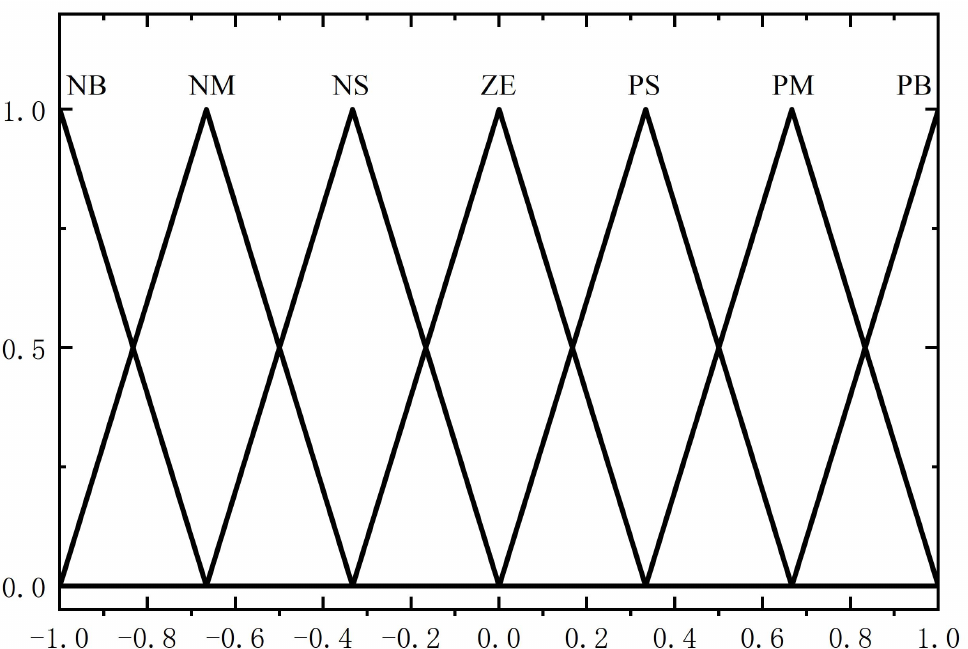
Figure 3. Fuzzy control affiliation